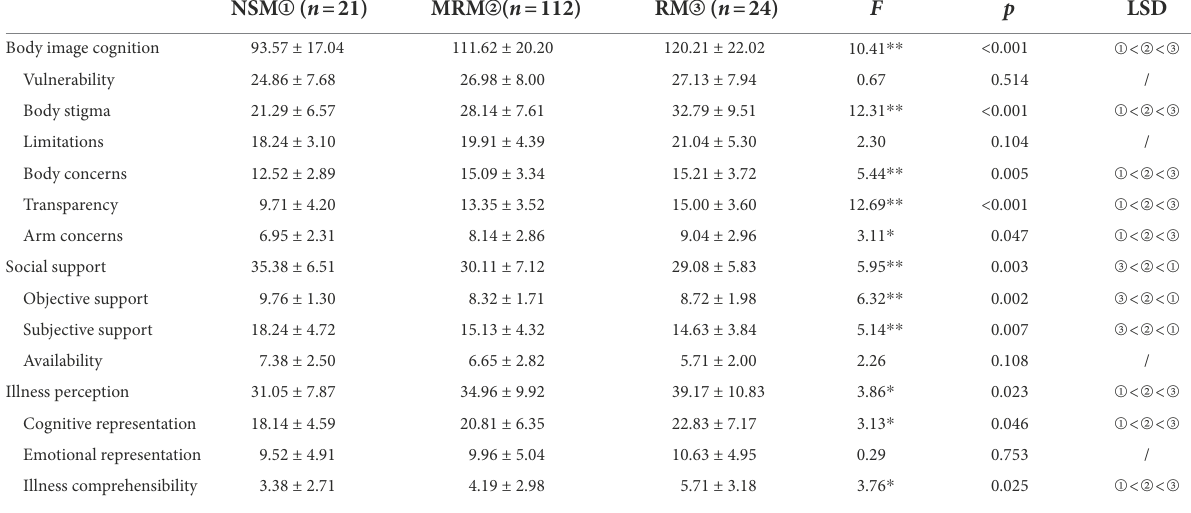
TABLE 3 The body image cognition, social support and illness perception scores after different surgical methods ( n =